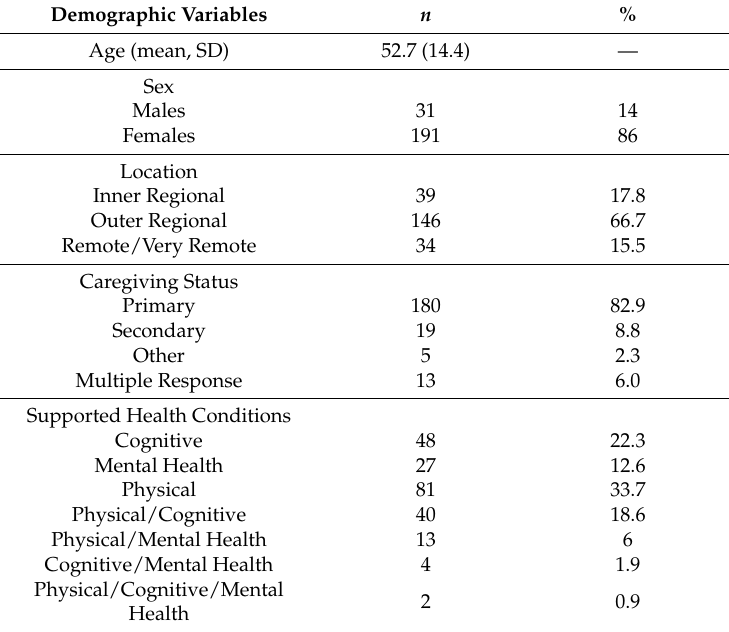
Table 1. Profile of rural